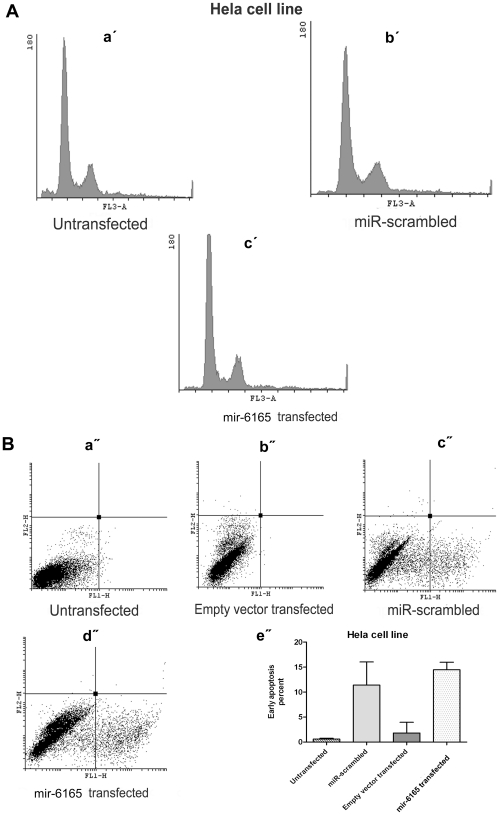
mir-6165 overexpression in Hela cell line.A) PI staining of Hela cells overexpressing Hsa-mir-6165 did not show any significant change in the stages of cell cycle after 34 hours post transfection (a′- c′). B) Annexin-PI staining of the Hela cells shown in figures a″- d″. Repeated Measures ANOVA analysis shows that the changes observed in annexin test of Hela cells were not significant between negative controls (scramble) and the test group (e″).